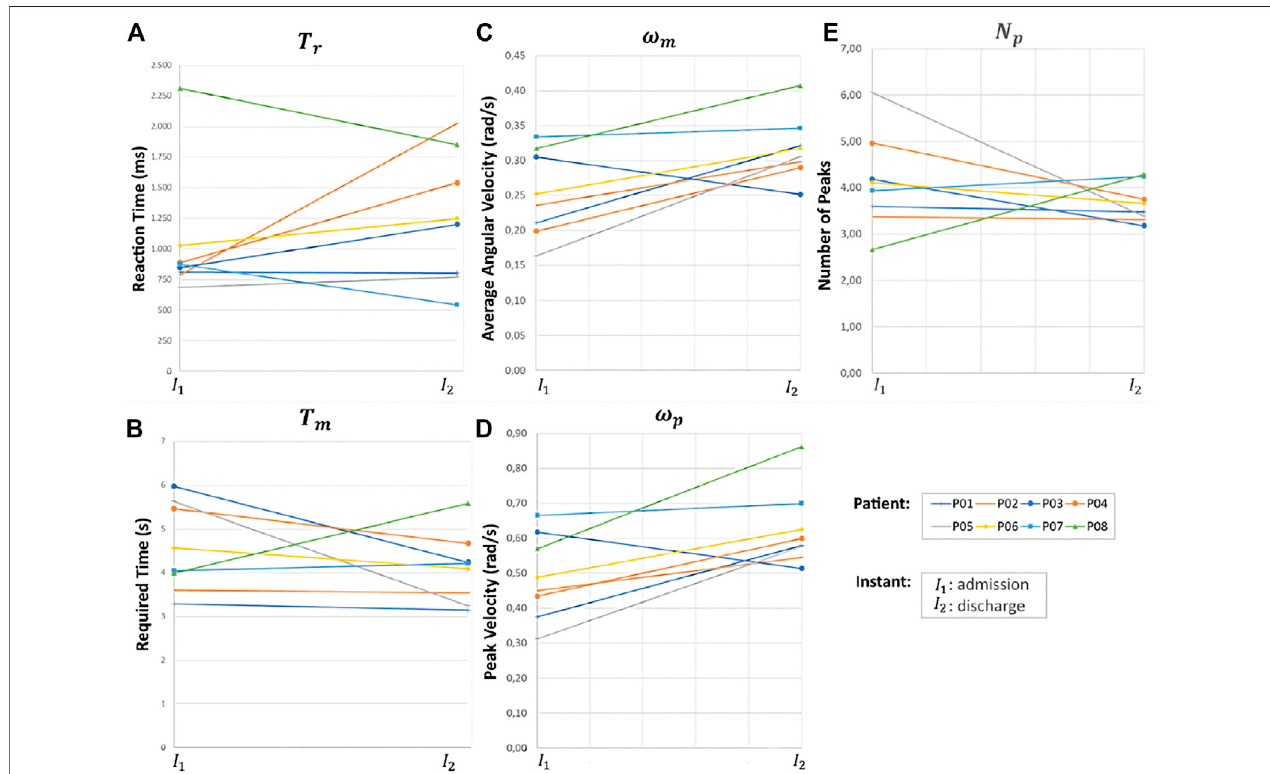
FIGURE 13 | Patients performance parameters between the admission-discharge of the RCT, (A) T r , (B) T m , (C) ω m , (D) ω p , and (E) N p .